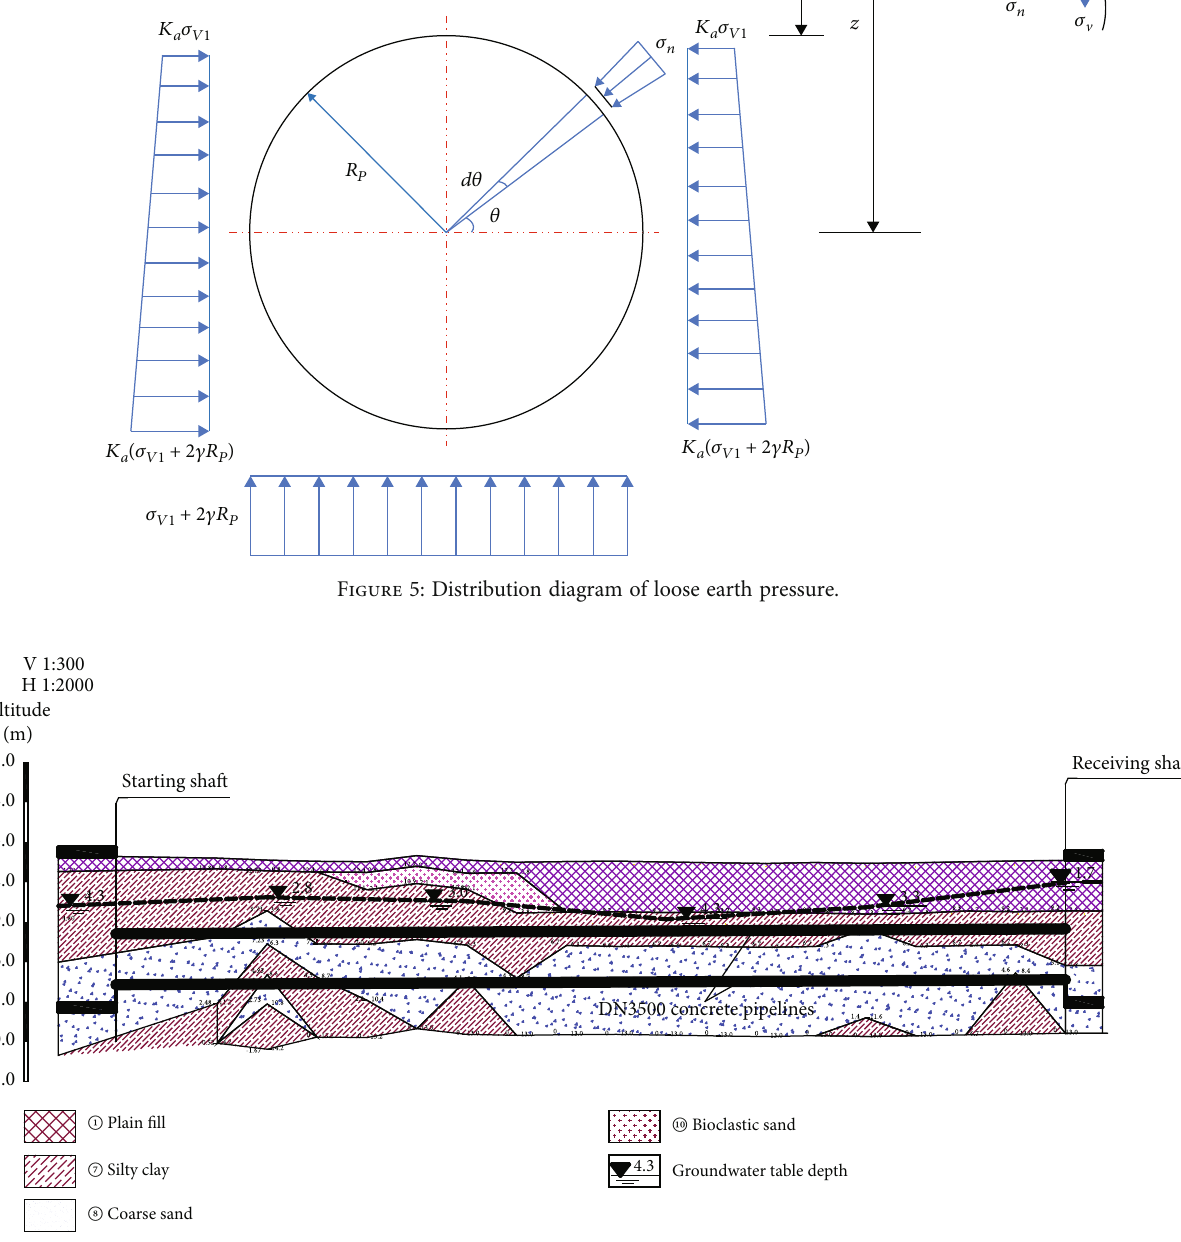
Figure 6: Geologic pro fi le of the pipe jacking